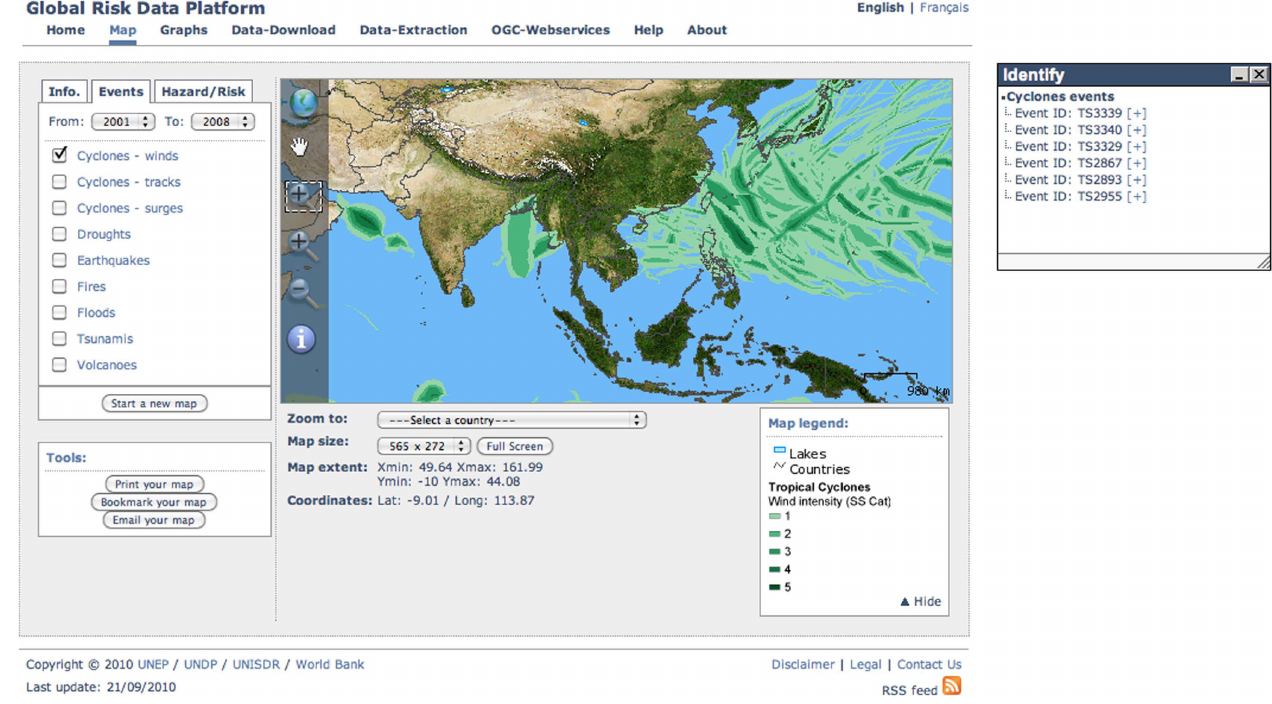
Fig. 3. Cyclones events from 2001 to 2008 in Asia as seen in the PREVIEW Global Risk Data